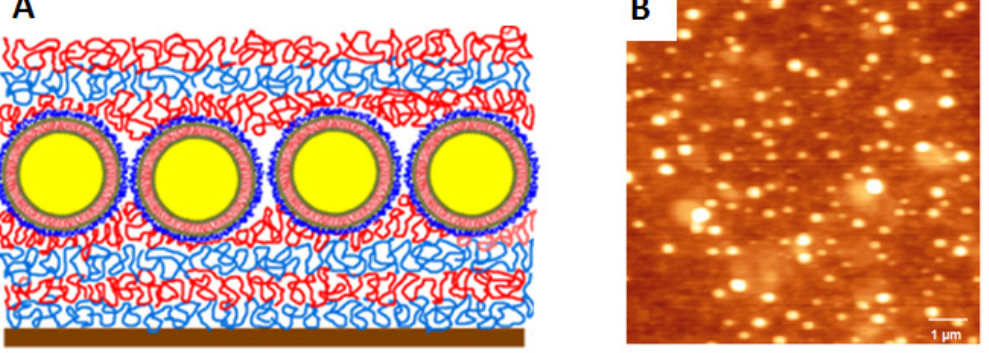
Figure 1. ( A ) Schematics of HA/PLL films with embedded liposomes assembled by the LbL method. PLL-in blue, HA-in red color; and ( B ) AFM image of the film with embedded vesicles. The film composition is (PLL/HA) /PLL-Liposome/HA/PLL/HA. Adopted from 12